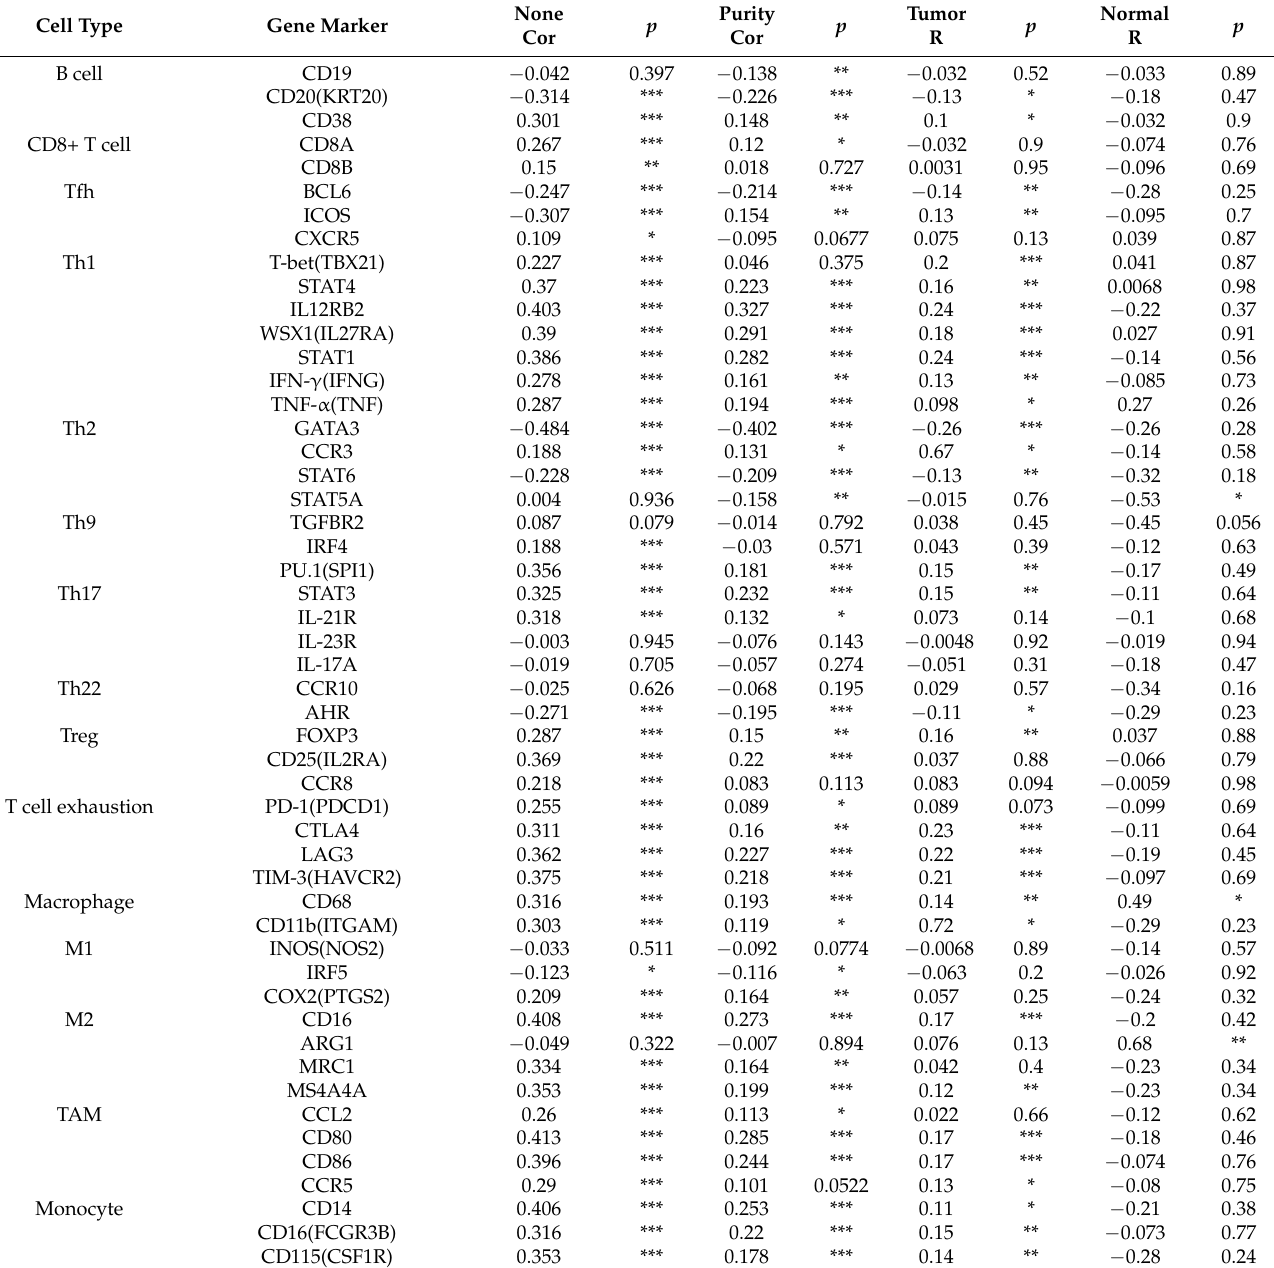
Table 2. Correlation analysis between CPA4 and markers of immune cells in BLCA patients found in the TIMER2 and